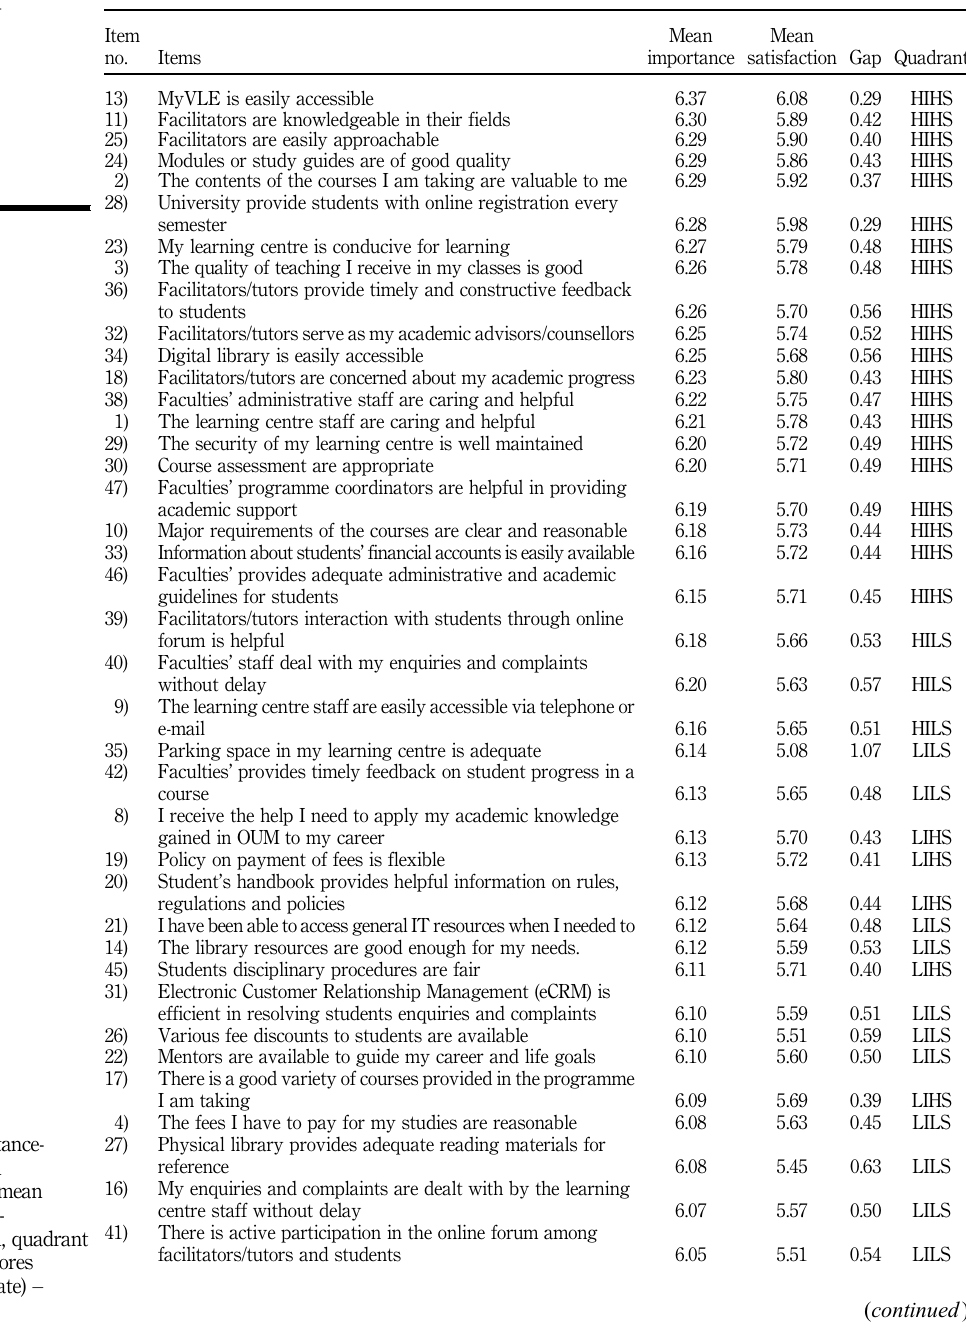
satisfaction inventory: mean importance- satisfaction, quadrant and gap scores (postgraduate) –